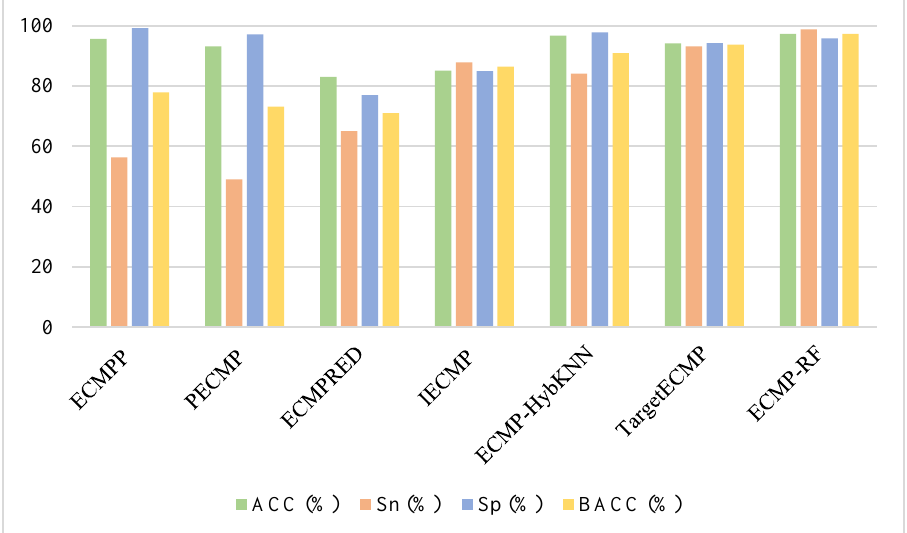
Figure 4. Comparison of ECMP-RF on training dataset with existing methods.